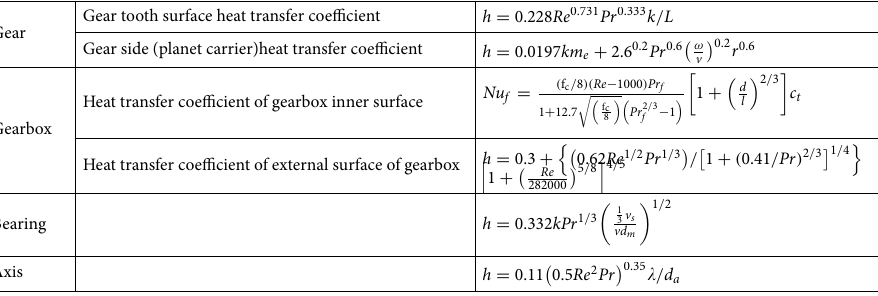
Table 3. Heat transfer coefficient calculation formula of